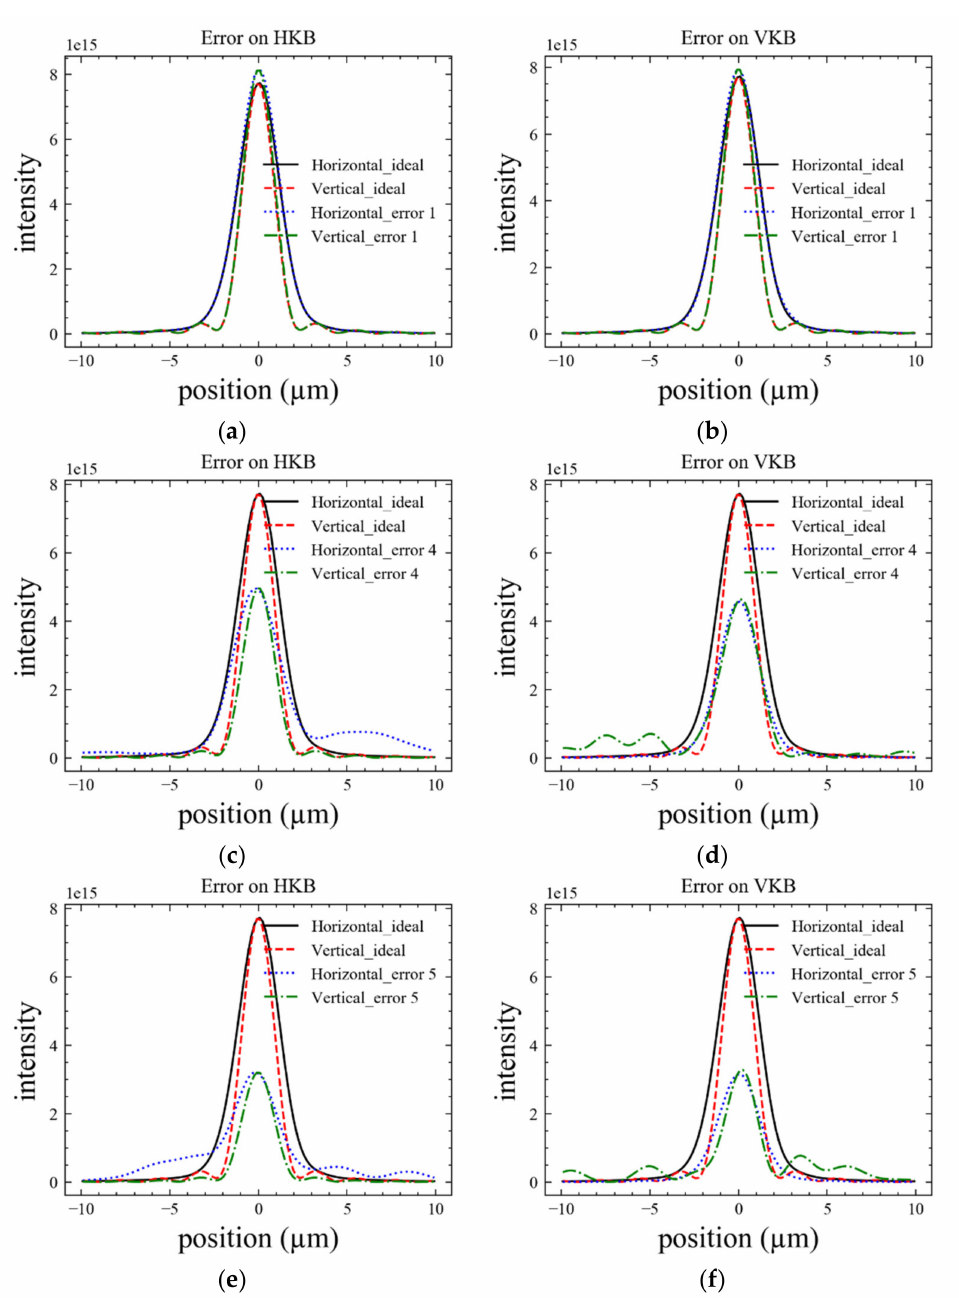
Figure 7. The plots of the intensity distribution with 5 µ rad acceptance angle for ( a , b ) CC1, ( c , d ) CC4, and ( e , f ) CC5. The error was added separately for ( a , c , e ); no error on